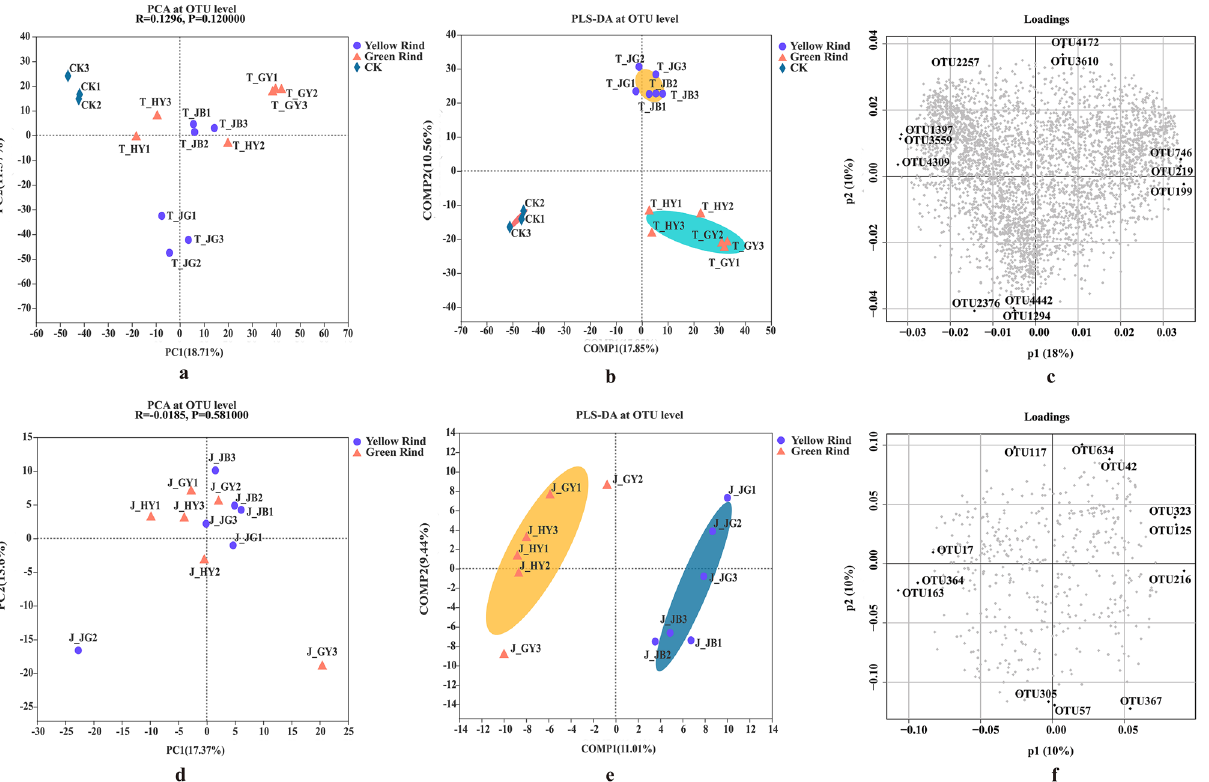
Figure 1. Comparison of soil bacteria in rhizosphere and endophytic bacteria between yellow and green rinds of watermelons. ( a ) PCA of soil bacteria communities at the OTU level. ( b ) PLS-DA score plot of soil bacteria communities in rhizosphere between yellow and green rinds of watermelons. ( c ) PLS-DA loading plot of soil bacterial communities in rhizosphere between yellow and green rinds of watermelons. ( d ) PCA of endophytic bacteria communities at the OTU level. ( e ) PLS-DA score plot of endophytic bacteria communities between yellow and green rinds of watermelons. ( f ) PLS-DA loading plot of endophytic bacterial communities between yellow and green rinds of